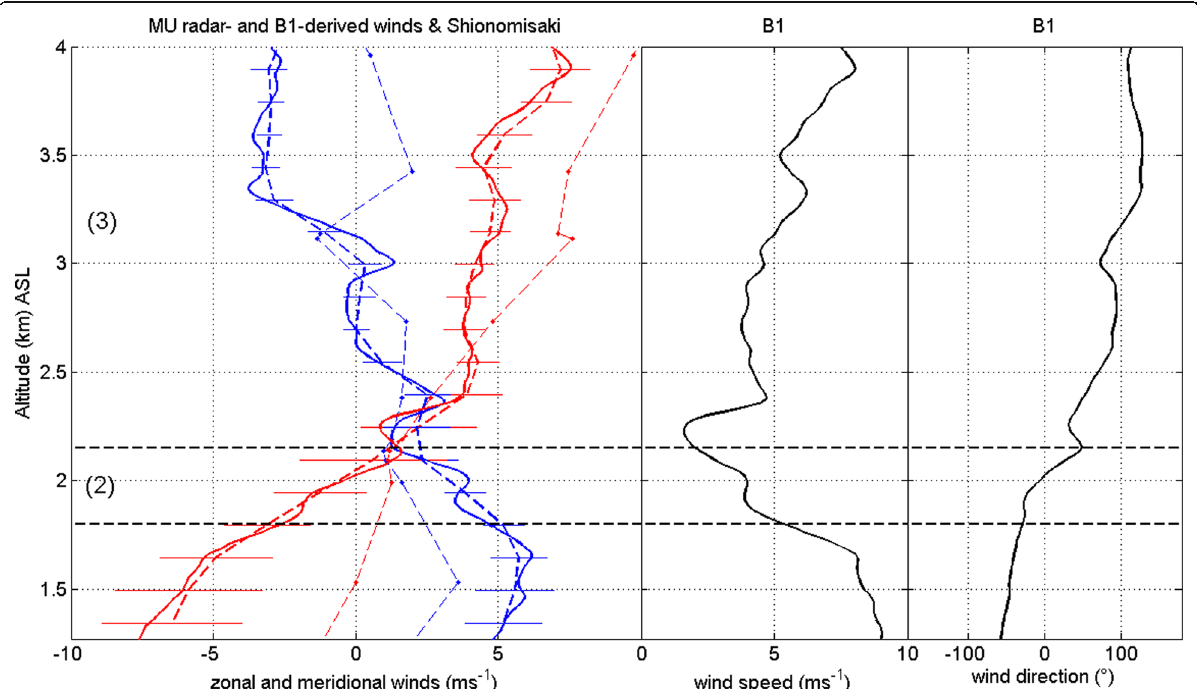
Fig. 4 (Left) Vertical profiles of zonal (red) and meridional (blue) winds derived from B1 (solid), MU radar (thick dashed), and a balloon launched at Shionomisaki station (light dashed). The MU radar-derived profiles have been averaged over 1 h (05:40 – 06:40 LT). The horizontal bars show the standard deviations of the radar estimates during B1 flight time. (Center) Wind speed profile from B1. (Right) Wind direction profile from B1. The horizontal dashed lines delineate the KH region